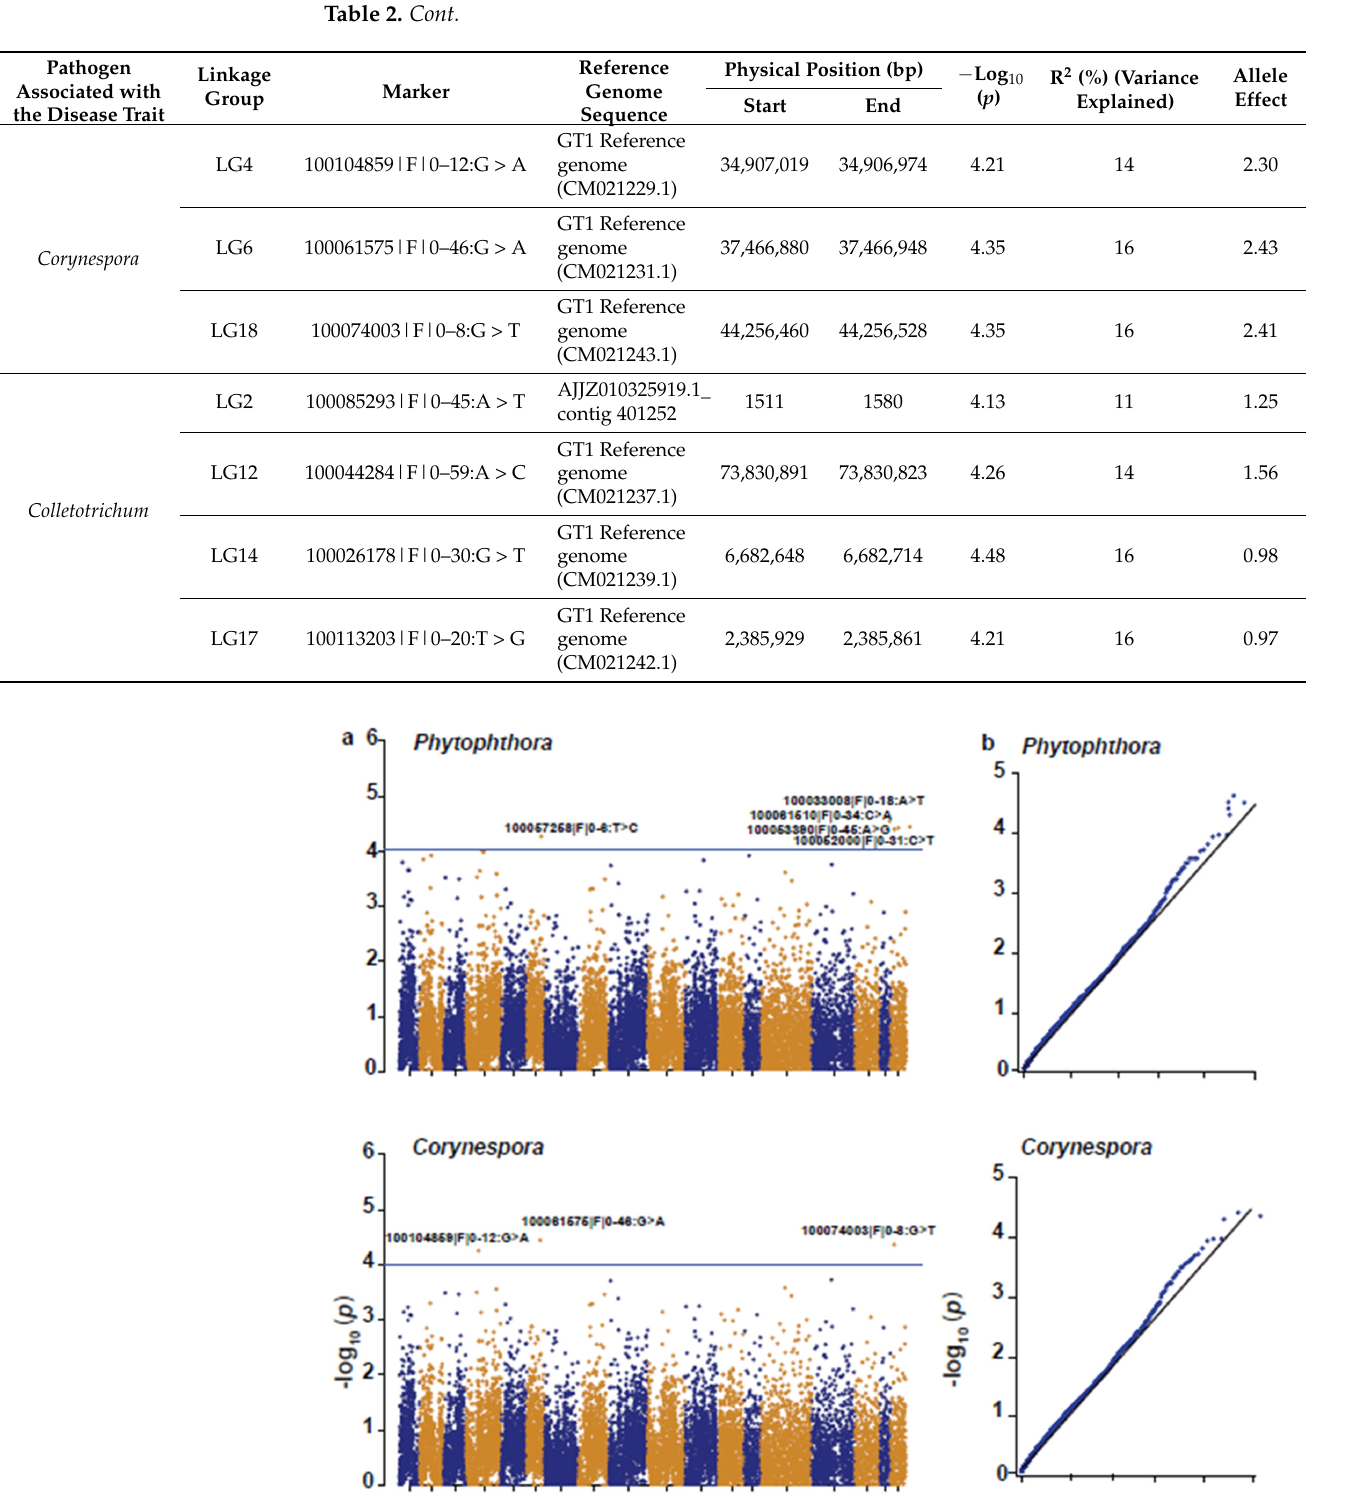
Figure 5. Manhattan plots and quantile ‐ quantile plots from marker ‐ trait association analysis for Phytophthora , Corynespora, and Colletotrichum resistance traits. In the Manhattan plots ( a ), each dot represents an SNP, showing the significance of its association with disease resistance ( − log 10 p ‐ value) (vertical axis) plotted against its genetic position (horizontal axis), and the horizontal blue lines indicate the genome ‐ wide significance threshold of p = 1.0 × 10 − 4 . In the quantile ‐ quantile plots ( b ), the black line represents the 95% confidence limit under the null hypothesis of no ‐ marker ‐ trait association, and the black dots represent p ‐ values.